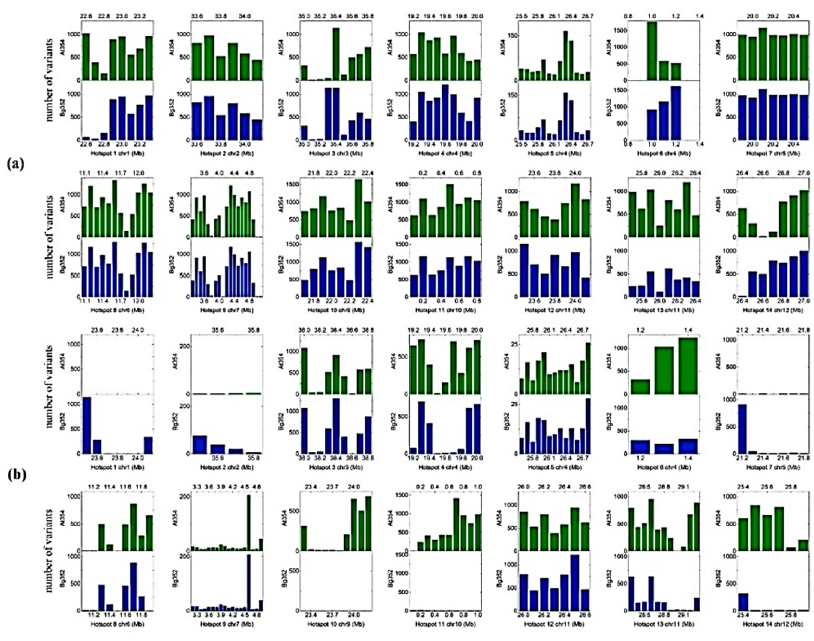
Figure 2. Location of 14 Quantitative Trait Loci (QTLs) on rice chromosomes and the total variants (SNPs and InDels) distribution within the QTLs in 100 kb windows. ( a ) with reference to Nipponbare, ( b ) with reference to R498.